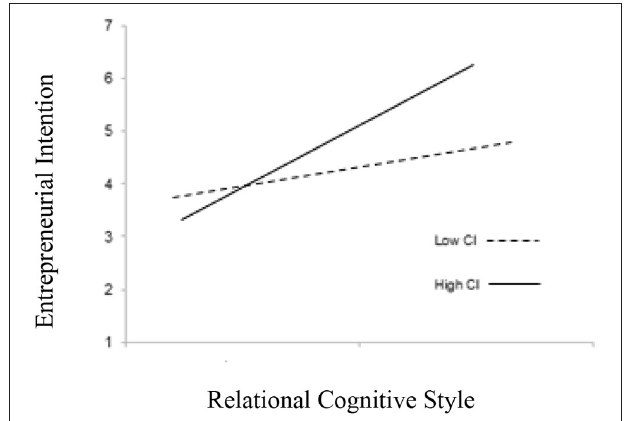
FIGURE 2 | Interaction effects of relational cognitive style and informal learning on entrepreneurial intention.